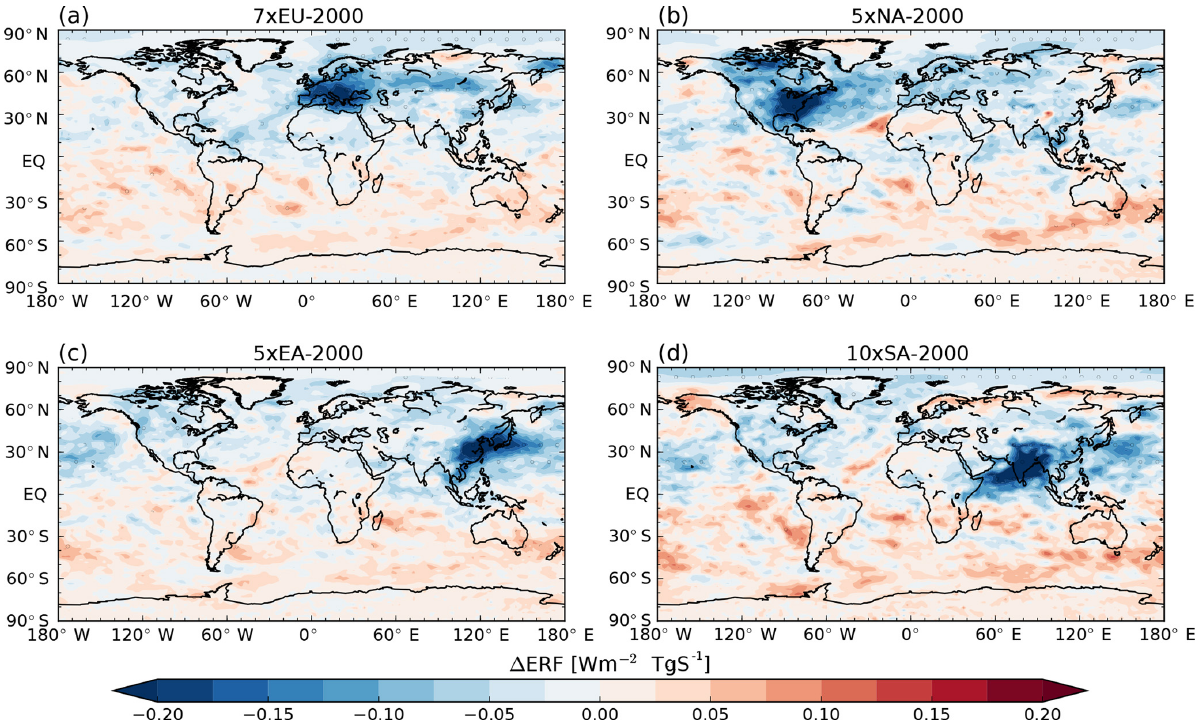
Figure 7. Global effective radiative forcing per unit SO 2 emission for (a) 7 × EU, (b) 5 × NA, (c) 5 × EA and (d) 10 × SA compared to the control simulation. Dots indicate where the result is statistically significant at the 95% confidence